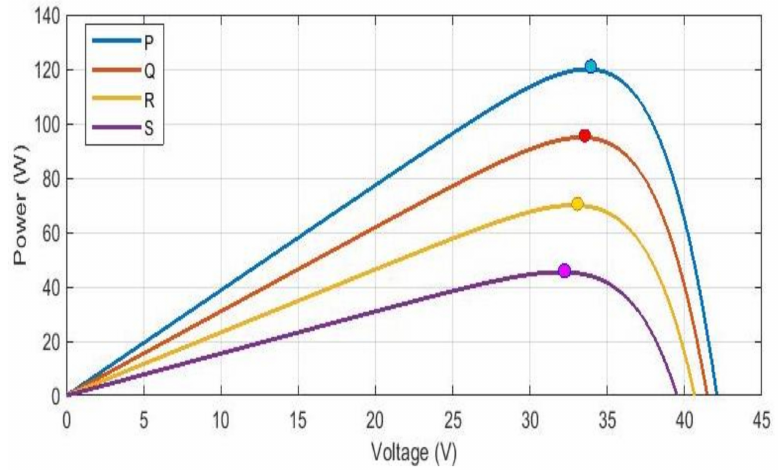
Figure 2. P-V curves under different uniform irradiance